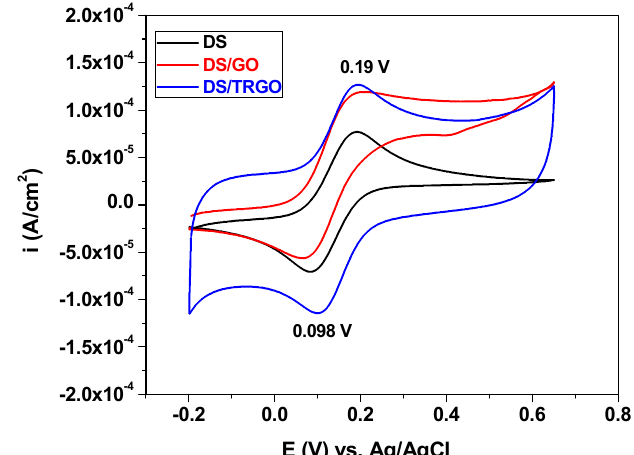
Figure 2. CVs showing the current density recorded with DS (black); DS / GO (red) and DS / TRGO (blue), in solution containing 1 mM K 4 [Fe(CN) 6 ] + 0.2 M KCl; scanning rate 10 mV / s.